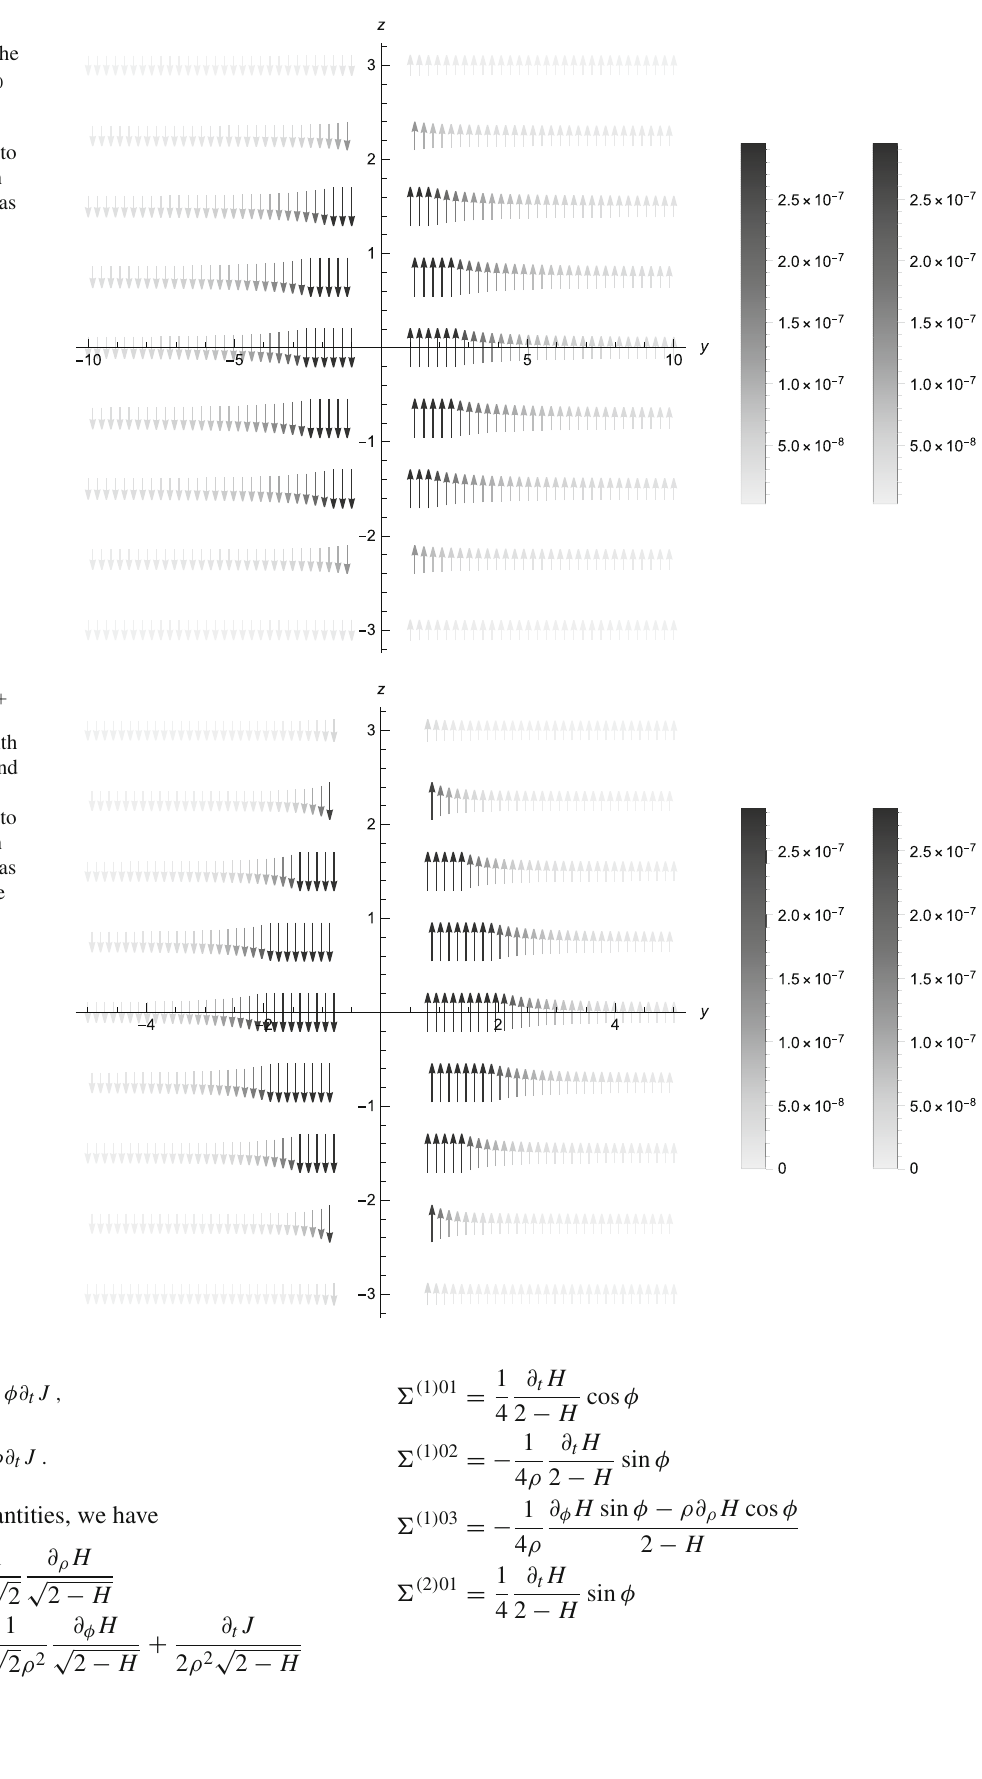
Fig. 1 Burgers vector for H 0 with t = x = 0 and C 0 = 1. The points were distributed with y 0 ranging from − 10 to − 1 and from + 1 to + 10, in steps of 0 . 05; and z 0 ranging from − 3 to + 3, in steps of 0 . 1. The region around the propagation axis was excluded from integration